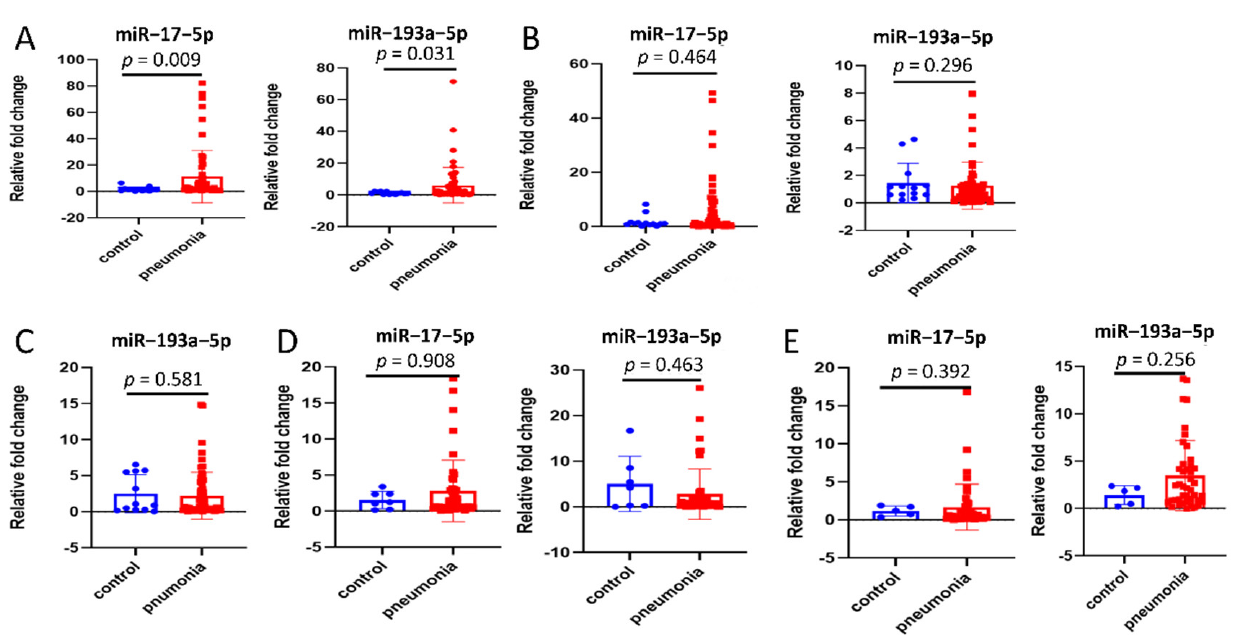
Figure 2. Differentially expressed miRNAs specifically shown in extracellular vesicles derived from bronchoalveolar lavage fluid (BALF-EVs). ( A ) Comparison of miR–17–5p and miR–193a–5p in BALF-EVs between control group (n = 13) and pneumonia group (n = 61). ( B ) Comparison of miR–17–5p and miR–193a–5p in cell-debris pellets derived from BALF (BALF-cell-debris pellets) between control group (n = 13) and pneumonia group (n = 61). ( C ) Comparison of miR–193a–5p in EVs-free supernatants derived from BALF (BALF-EVs-free supernatants) between control group (n = 13) and pneumonia group (n = 61). ( D ) Comparison of miR–17–5p and miR–193a–5p in EVs derived from plasma (plasma-EVs) between control group (n = 7) and pneumonia group (n = 48). ( E ) Comparison of miR–17–5p and miR–193a–5p in total plasma between control group (n = 5) and pneumonia group (n = 44). Data presented as a relative fold change for each miRNA. Box plots are displayed, where the horizontal bar represents the median, the box represents the IQR, and the whiskers represent the maximum and minimum values. Comparisons were made using the Mann–Whitney U test. IQR, interquartile range.